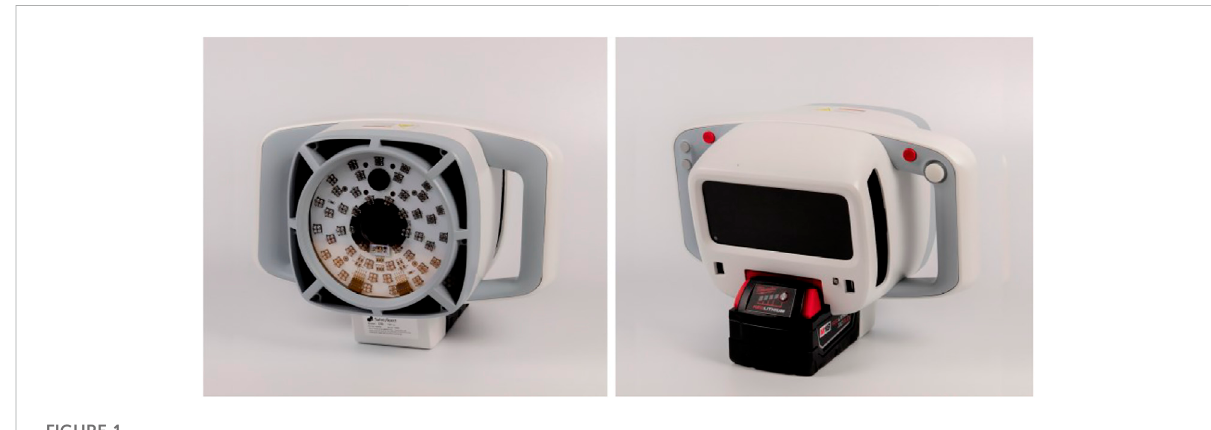
FIGURE 1 CSI-D device, Front view, and Rear view.